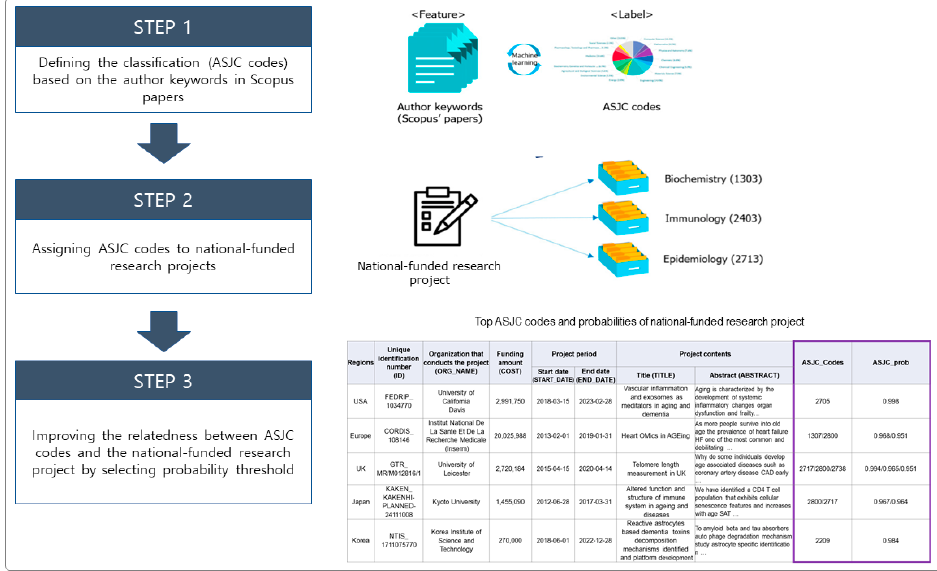
Figure 2. The process of assigning ASJC codes to national-funded research projects and improving the relatedness between the ASJC codes and the projects.